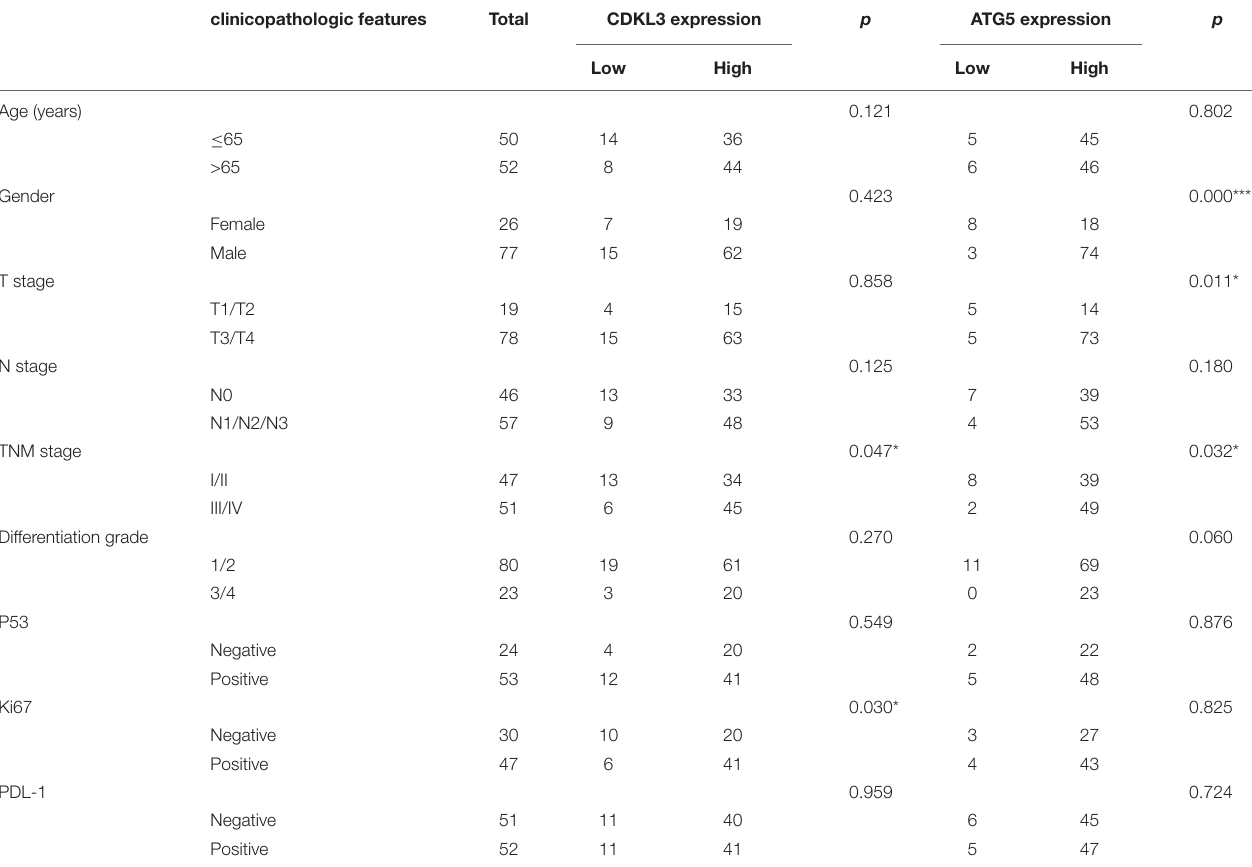
TABLE 2 | The relationship between CDKL3 and ATG5 expression status and clinicopathologic features of ESCC. clinicopathologic features Total CDKL3